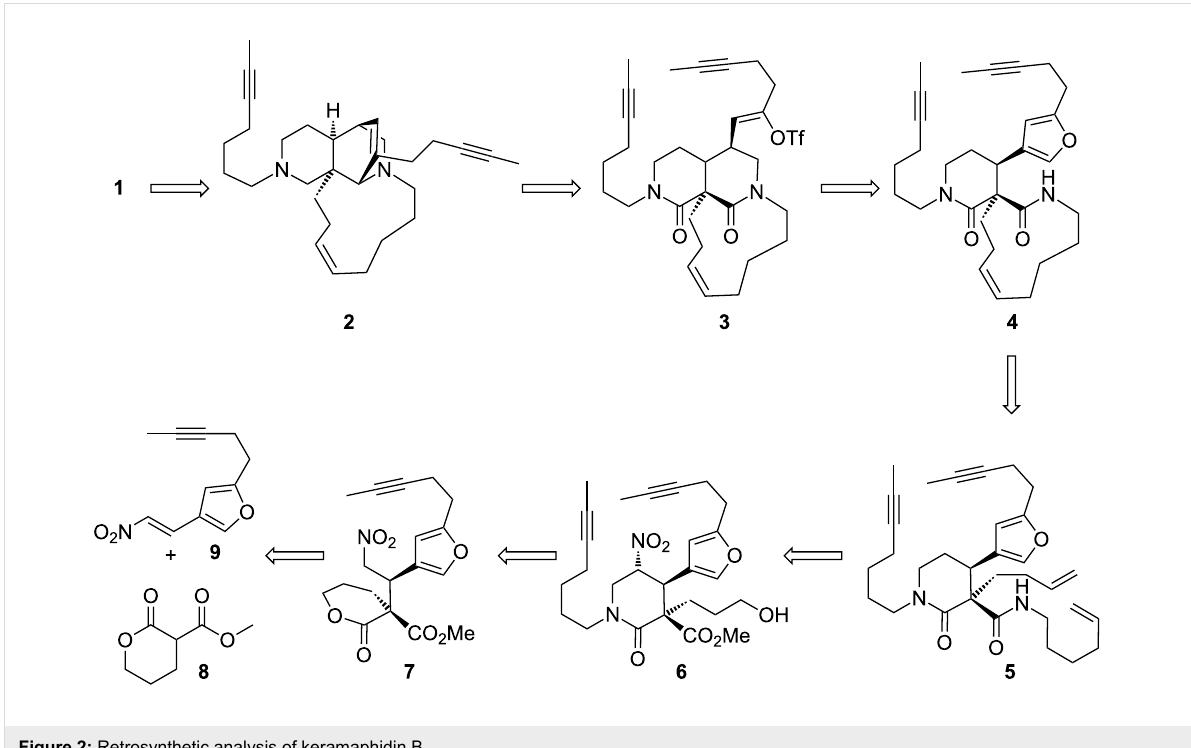
Figure 2: Retrosynthetic analysis of keramaphidin B.